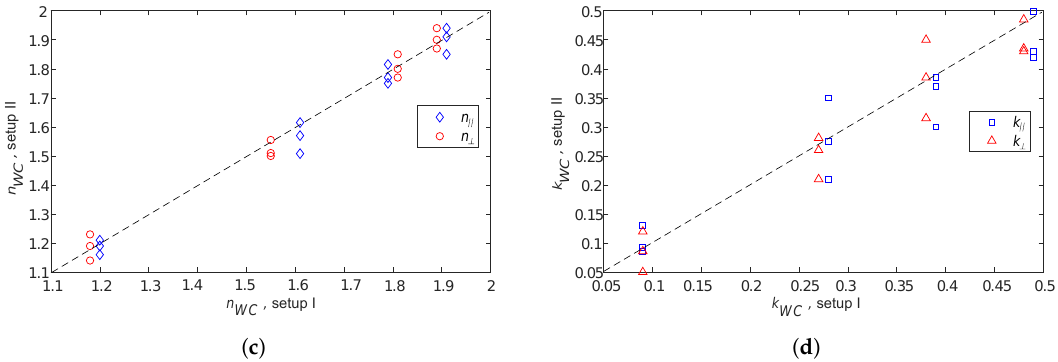
Figure 10. Comparison of the refractive index for SW and WCs as measured by the two different set up geometries (Setups I and II) for different moisture content values: ( a ) the real part, n , of SW (Object C vs. Object A), ( b ) the imaginary part, k , of SW (Object C vs. Object A), ( c ) the real part, n , of WCs (Object D vs. Object B), and ( d ) the imaginary part, k , of WCs (Object D vs. Object